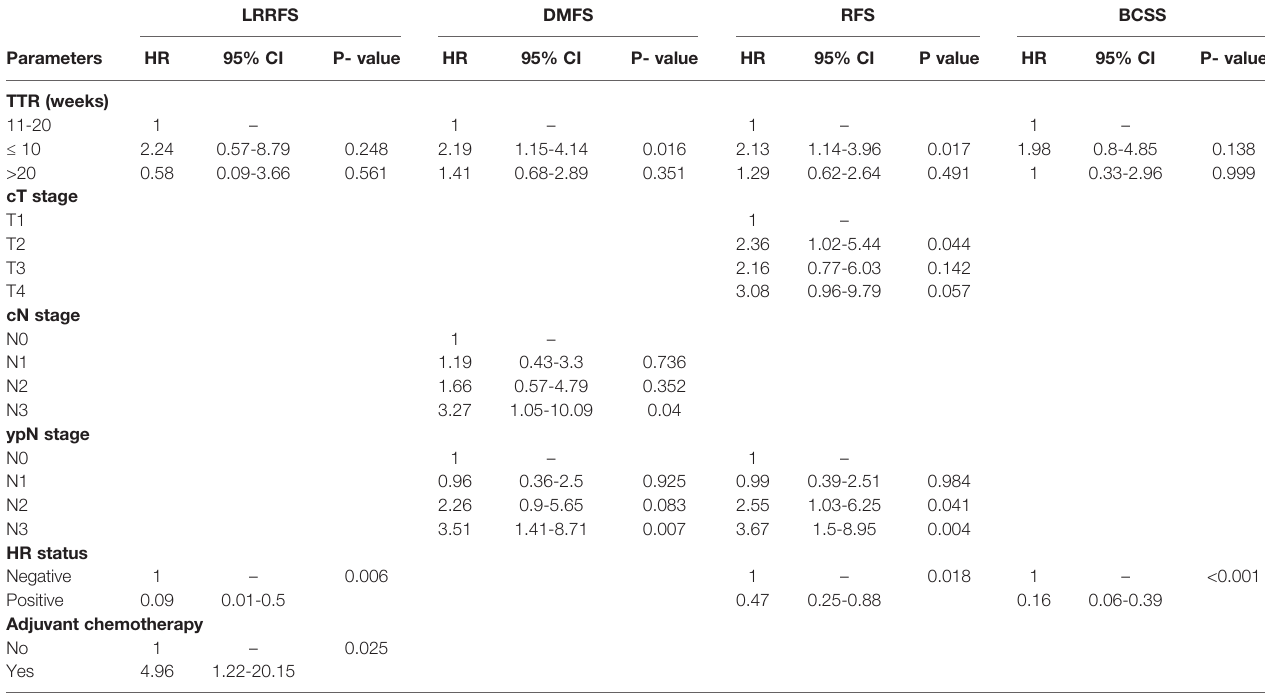
TABLE 3 | Adjusted hazard ratio (HR) of survival outcomes by TTR in the multivariable Cox proportional hazards model.